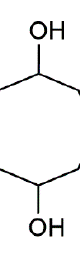
Figure 8. Structure of α , α -cyclodiglycerol.